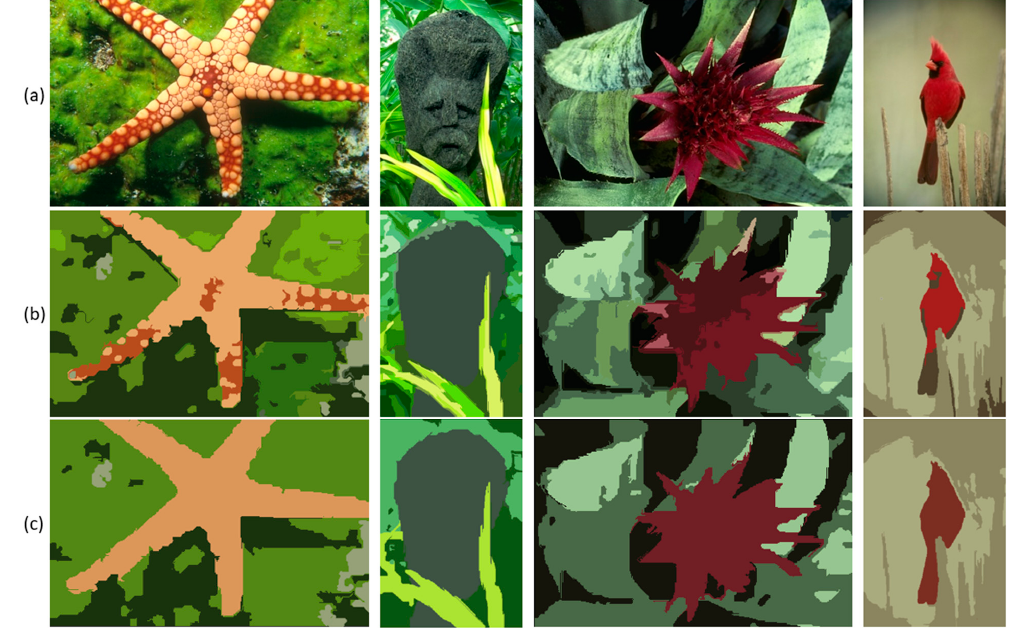
Figure 8. Comparison of segmentation results with and without K-means post-processing. From top to bottom: ( a ) Original images, ( b ) w / o K-means refinement, a lot of unwanted segment regions are formed (e.g., starfish has dark colored spots, flower is also segmented into two segments, and the same with the bird, as it has two di ff erent colored segments), ( c ) w K-means refinement step, one object is given only one label.